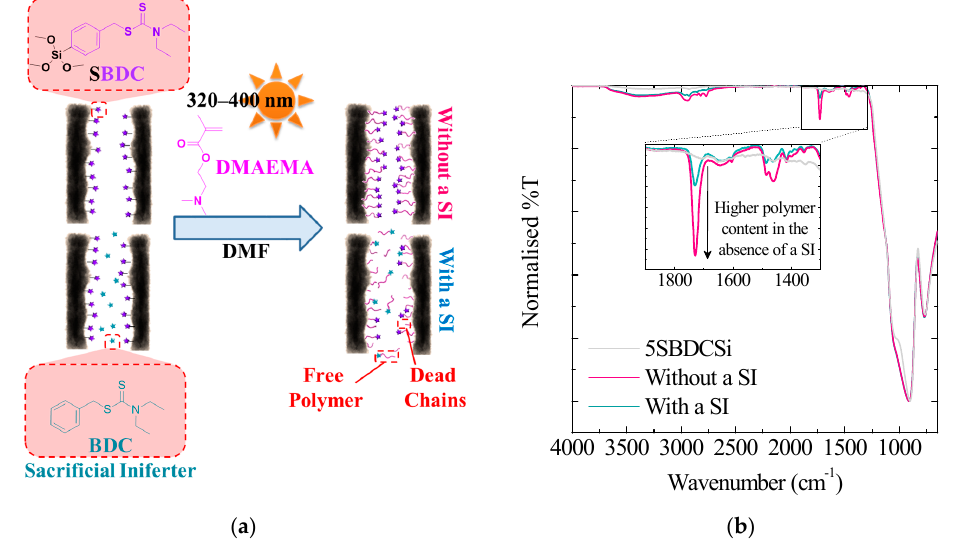
Figure 4. ( a ) Schematic diagram depicting the potential increased termination under confinement in the presence of a SI, BDC, leading to a reduced polymer amount as shown by ( b ) IR spectroscopy.